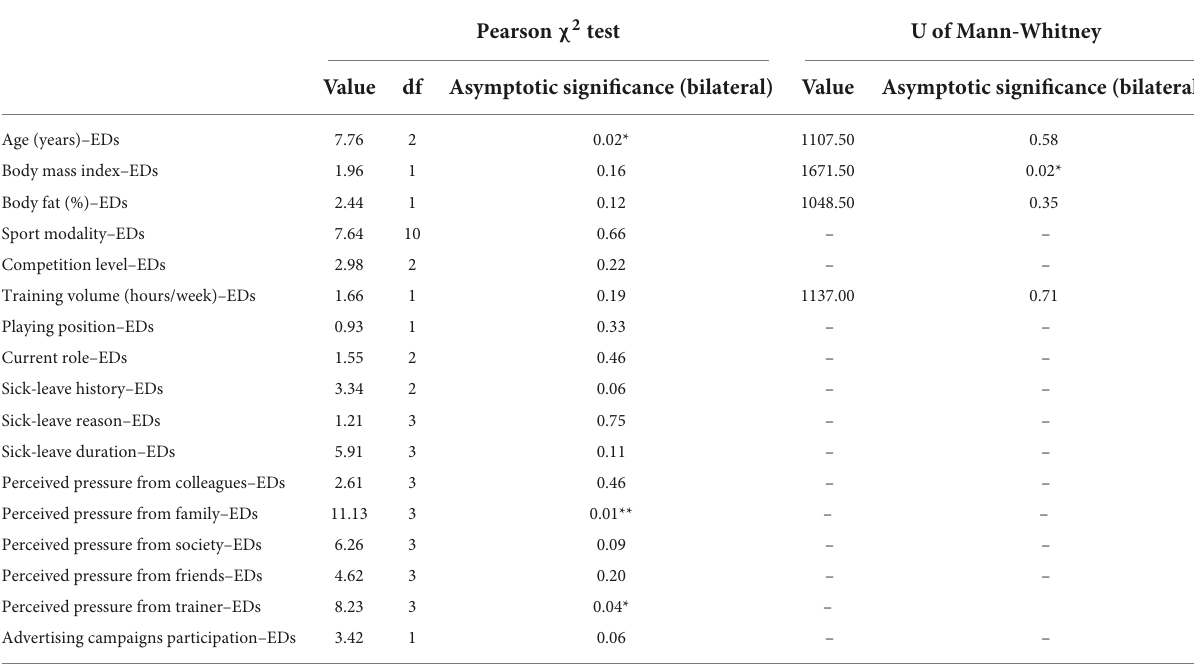
TABLE 2 Results of pearson χ 2 and U of Mann–Whitney